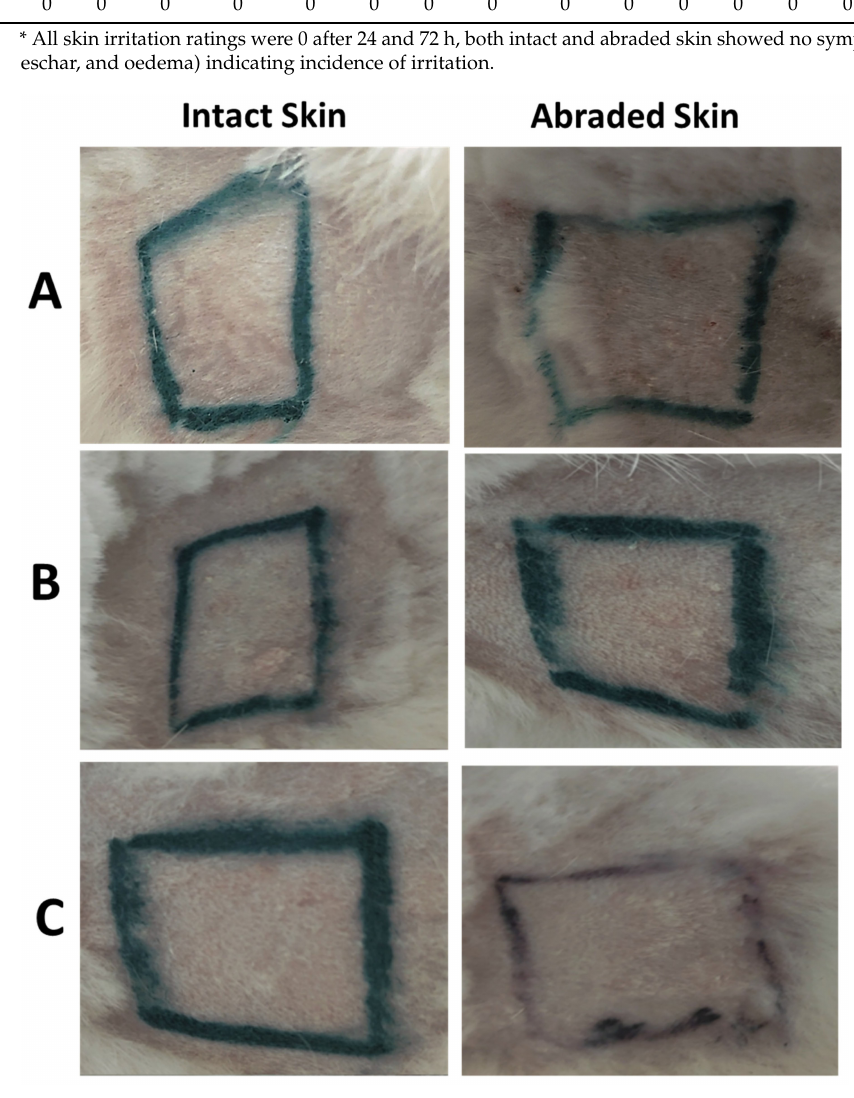
Figure 3. Representative photos of the skin irritation test for one representative rabbit for ( A ) Group I; untreated group, act as a control, ( B ) Group II; rhamnolipids nano-micelles solution (0.625 mg/mL) dispersed in PBS (10 mM, pH 7.4) treated group, and ( C ) Group III; PBS (10 mM, pH 7.4) treated group. Black lines were drawn with a non-irritating pen. No differences in score were observed after 72 h between the test and control site for both abraded and intact